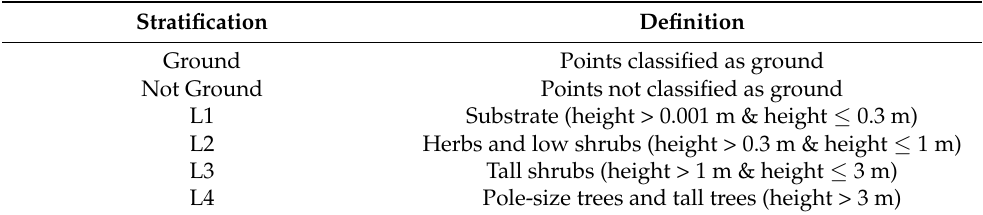
Table 1. Height bins and stratifications used in